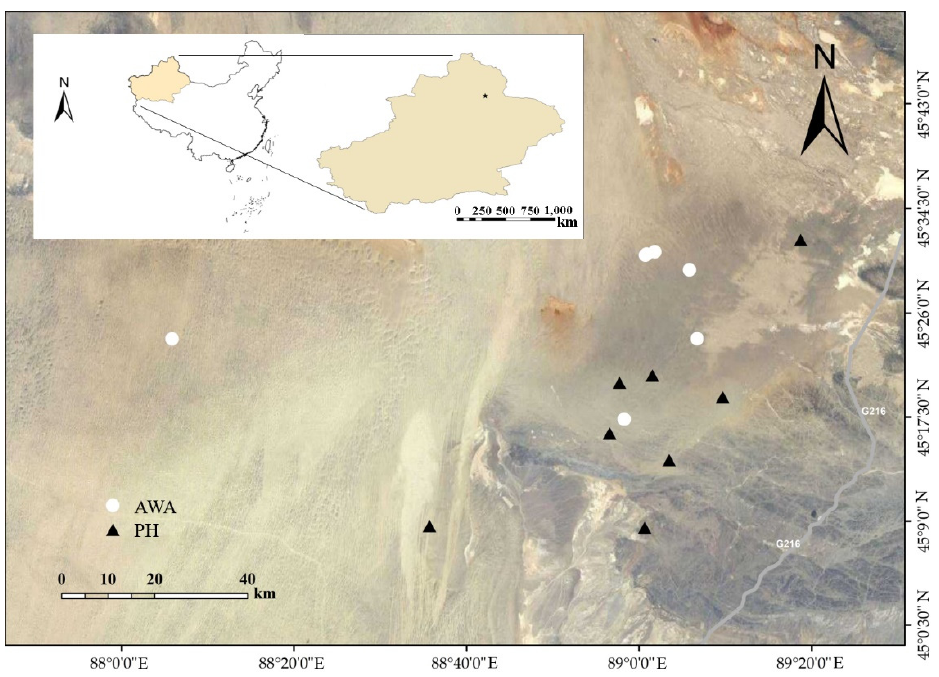
Figure 1. Locations of the sampling site for Przewalski’s horse (PH, dark triangles) and Asiatic wild asses (AWA, white dots) in Kalamaili Mountain Ungulate Nature Reserve.